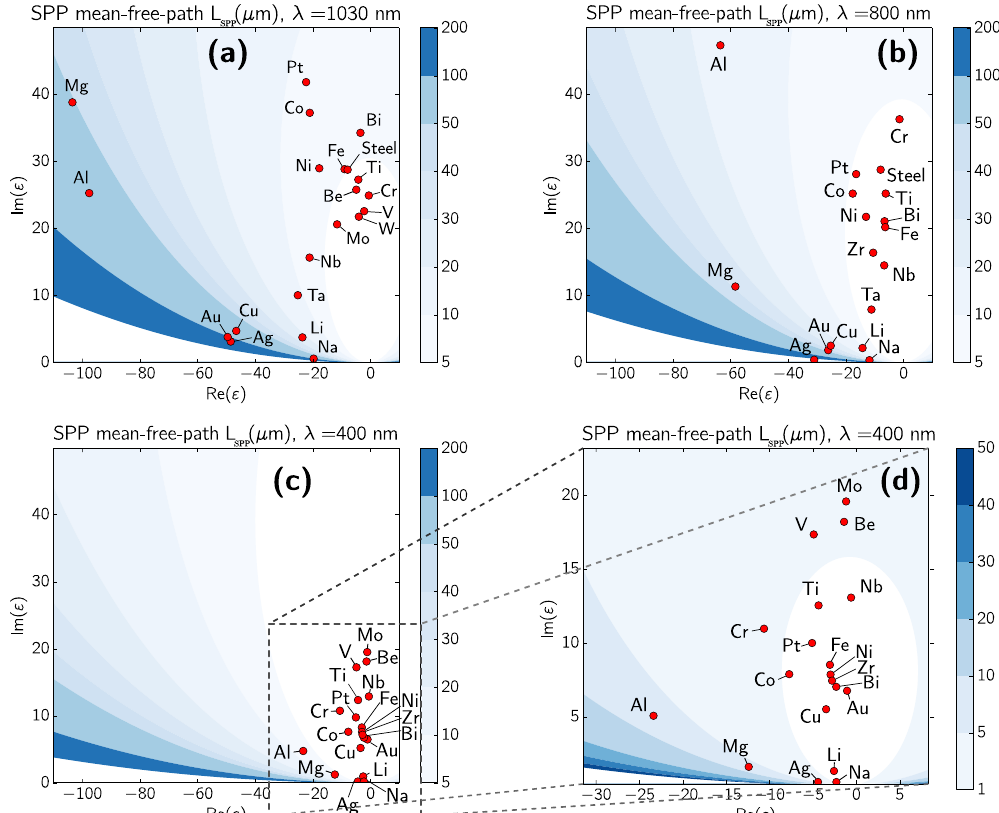
Figure 3. SPP mean free path L SPP for different metals at three laser wavelengths λ = 1030 nm ( a ), 800 nm ( b ) and 400 nm ( c , d ). According to our predictions, metals with small L SPP (located in the bright regions) are suitable for HR-LIPSS generation at the corresponding laser wavelengths. Color scales are given in